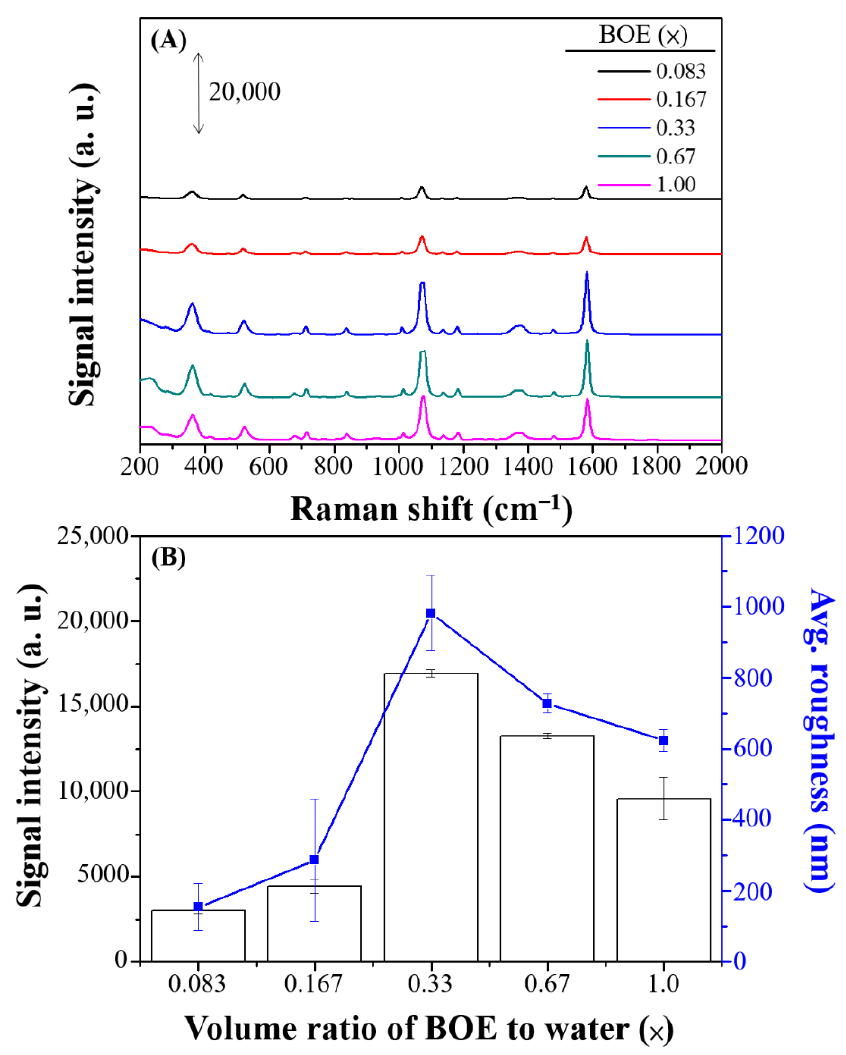
Figure 5. ( A ) SERS spectra and ( B ) Raman intensity and average roughness (nm) of 100 µ M 4-MBA on Ag nanostructures prepared with various volume ratios of BOE to deionized water (0.083 × , 0.167 × , 0.33 × , 0.67 × , and 1.00 × ). The error bars represent the standard deviations by using three batches of Ag substrates for which the average signal of 10 spots per sample are recorded.